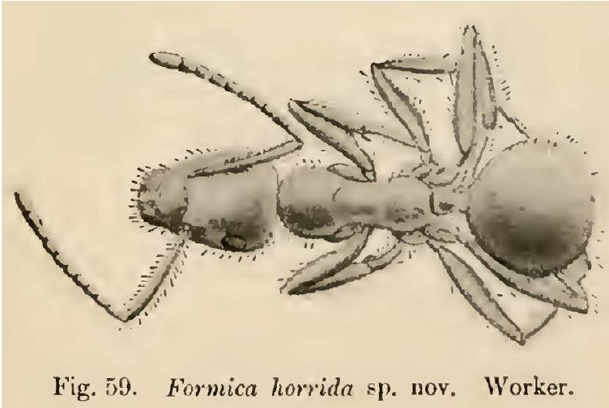
Fig 8 . Formica horrida drawing. Reproduced from Wheeler 1915: